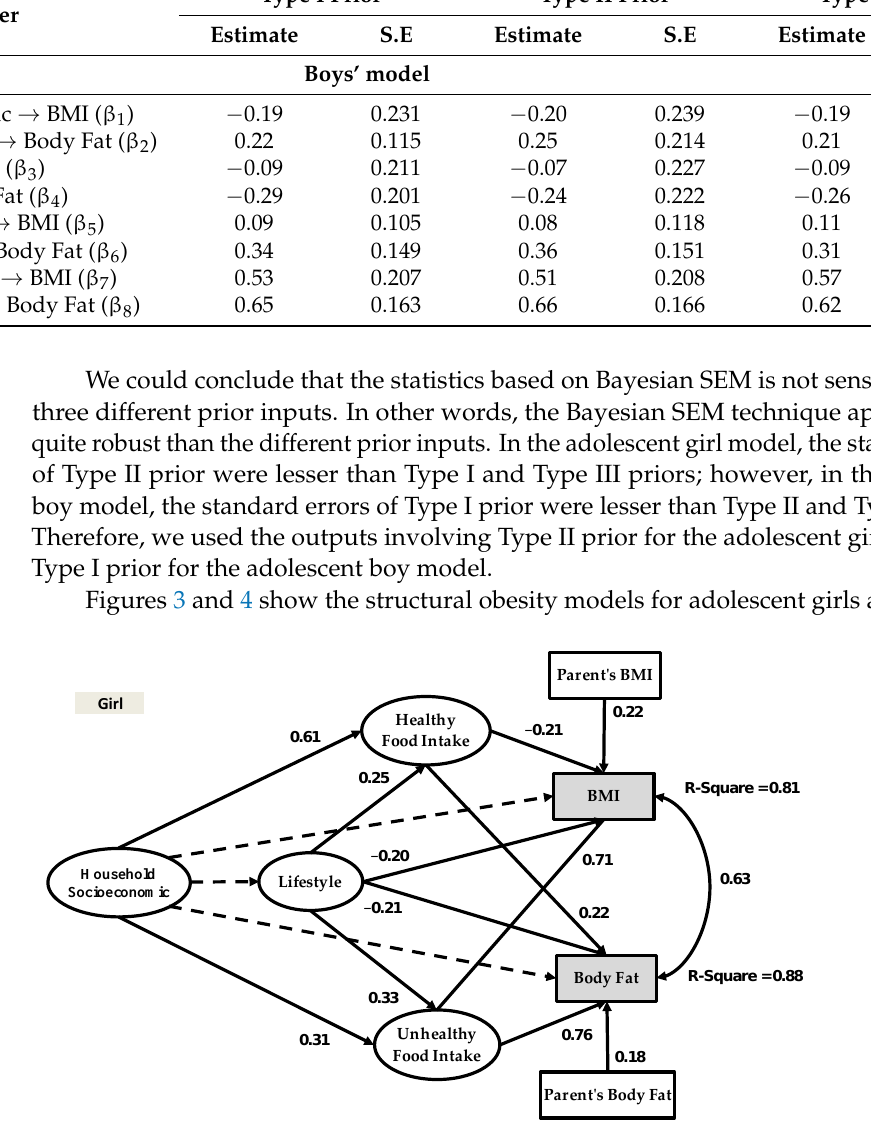
intake (Beta = 0.33). However, the relationships among research variables in the adolescent boy model were different than those in the adolescent girl model. Based on Figure 4, household socioeconomic had a significant impact on healthy food intake (Beta = 0.41), BMI (Beta = − 0.19), lifestyle (Beta = 0.31), and body fat (Beta = 0.22); however, this variable had no significant impact on unhealthy food intake. Meanwhile, in the adolescent boy model, lifestyle had a significant impact on body fat (Beta = − 0.29) and unhealthy food intake (Beta = 0.37); however, this variable had no significant impact on healthy food intake and